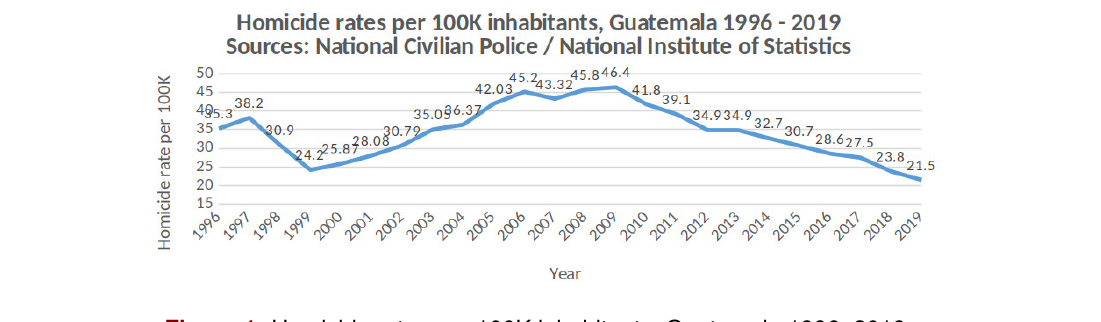
Figure 1. Homicide rates per 100K inhabitants, Guatemala 1996–2019.